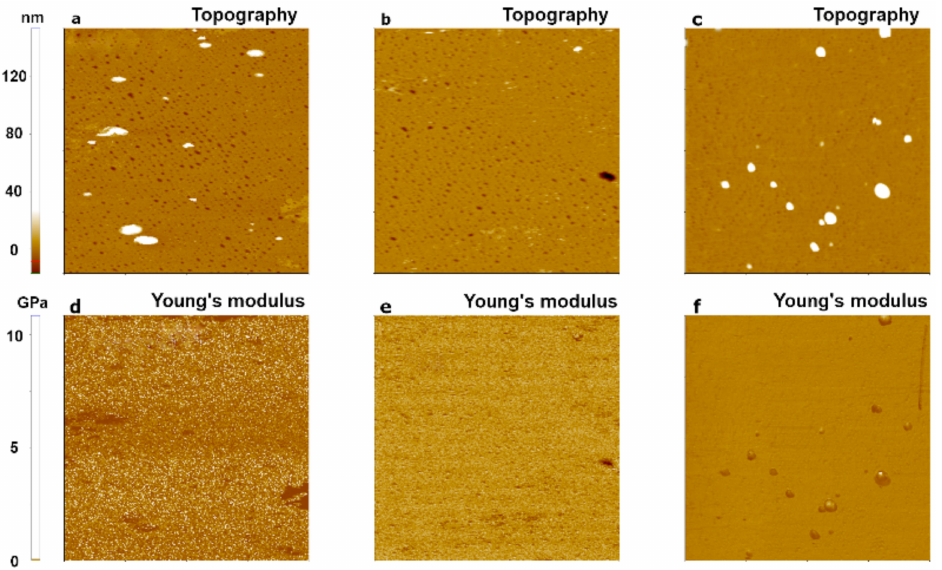
Figure 7. PinPoint TM nanomechanical images of a PS sample using three cantilevers with different spring constants: 0.2 N/m for CONTSCR ( a , d ), 2.8 N/m for FMR ( b , e ), and 42 N/m for NCHR ( c , f ). The size of all images was 10 µ m × 10 µ m.